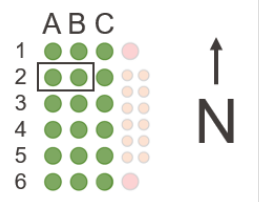
Fig. 6. Identification of fuel rods in COLIBRI. Fuel rods oscillated during this campaign are circled in black, with A2 the instrumented one.